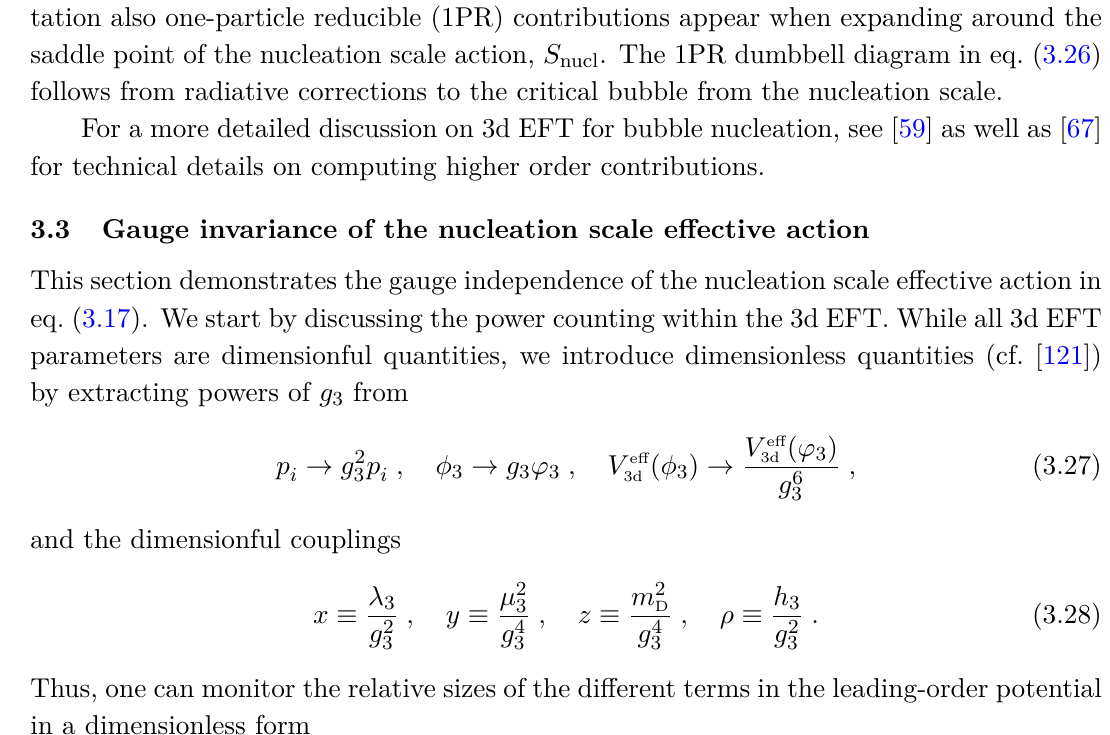
gT suppresses contributions to the nucleation ∼